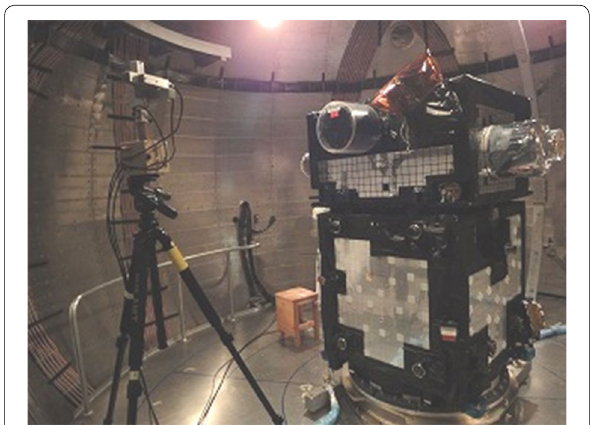
Fig. 5 System electromagnetic compatibility (EMC) test conducted, while the whole satellite system is inside a magnetic‑shielded room